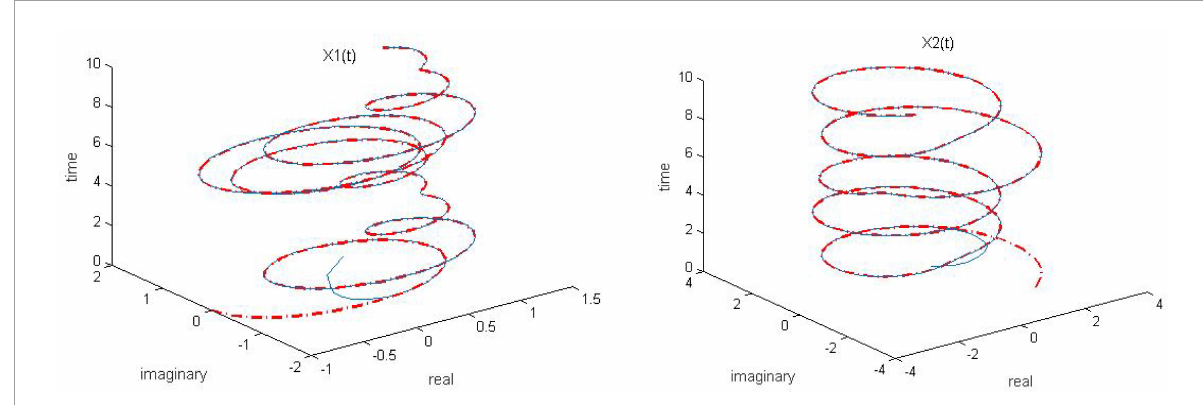
FIGURE6 Dynamic complex matrix equation (DCME) (1) solved by robust zeroing neural network (RZNN) model (11) with k = 0.5 in n(t) = 0.5 polluted environment.